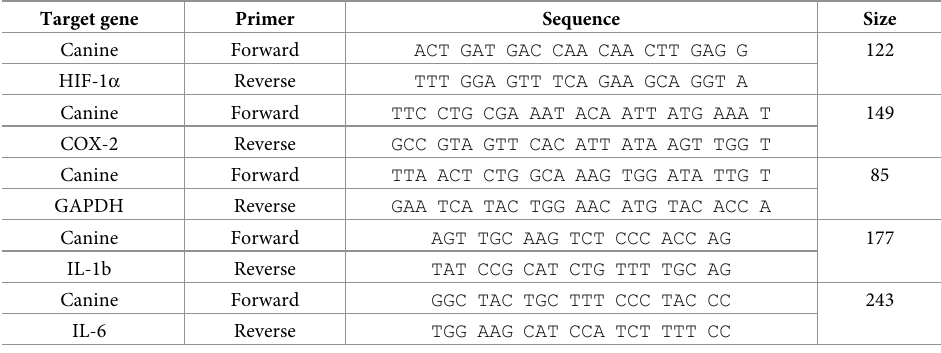
Table 1. Sequences of PCR primers used in this